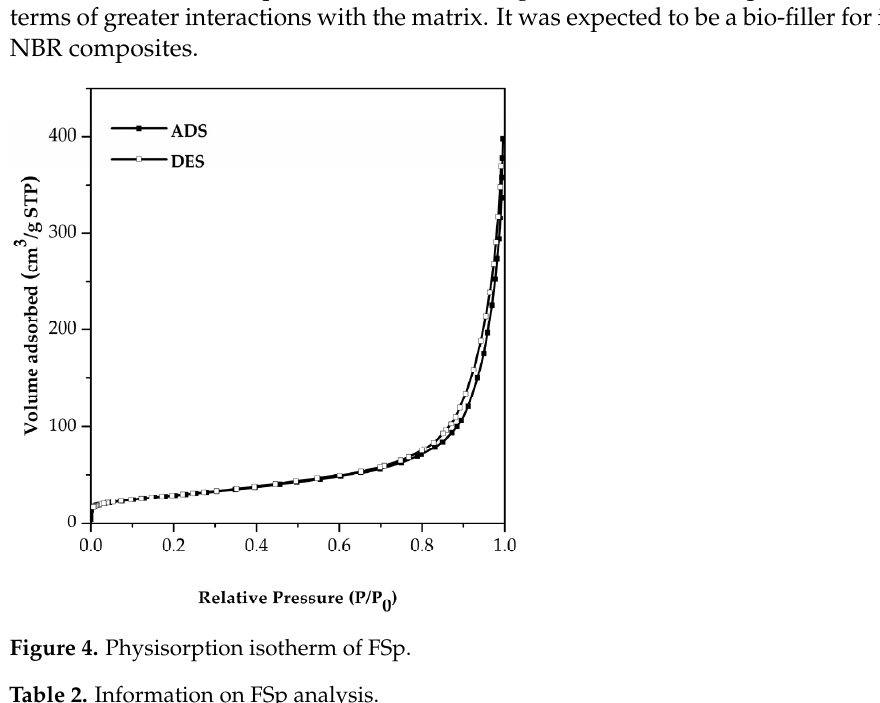
Figure 3. FTIR spectrum of FSp.